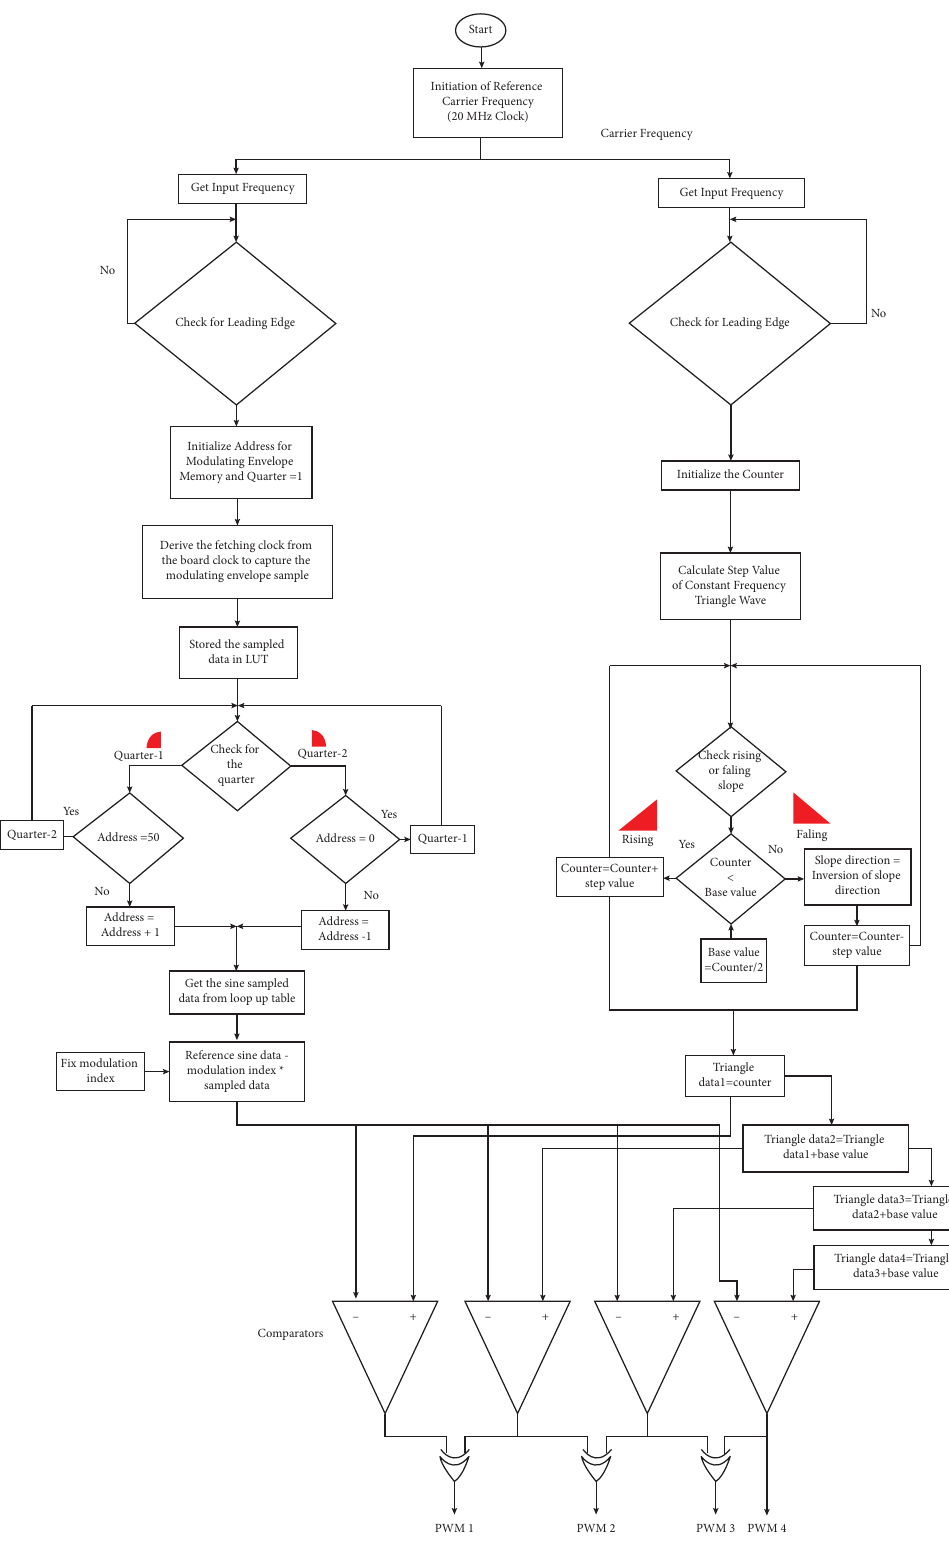
Figure 18: Experimental fow chart for FPGA pulse